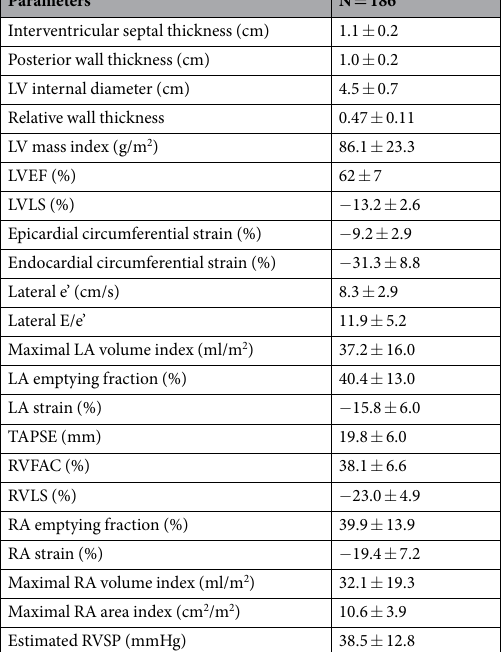
Parameters N = 186